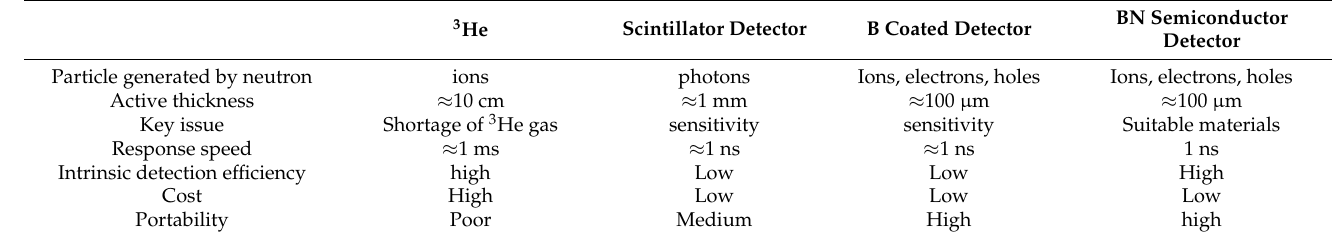
Table 3. Neutron detector-type comparison (Reprinted/adapted with permission from Ref. [31]. Copyright 2011, Elsevier).